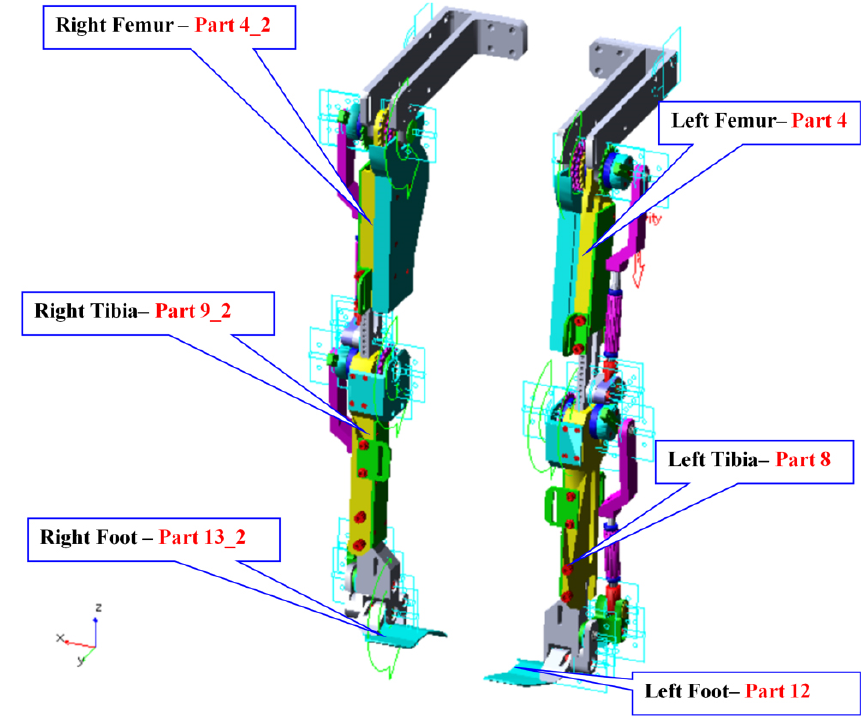
Figure 9. Exoskeleton parametrized virtual model with proper joints prepared for virtual simulations in a dynamic mode.